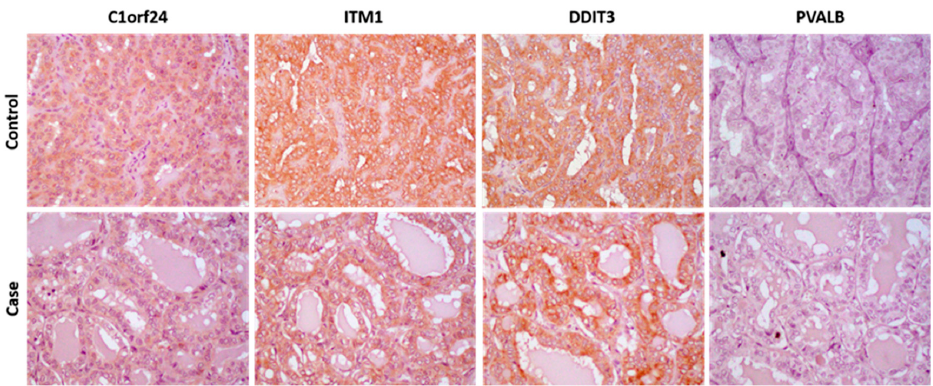
Figure 2. Representative results of molecular markers in WTC and non-WTC thyroid carcinomas ( original magnification of x40) .